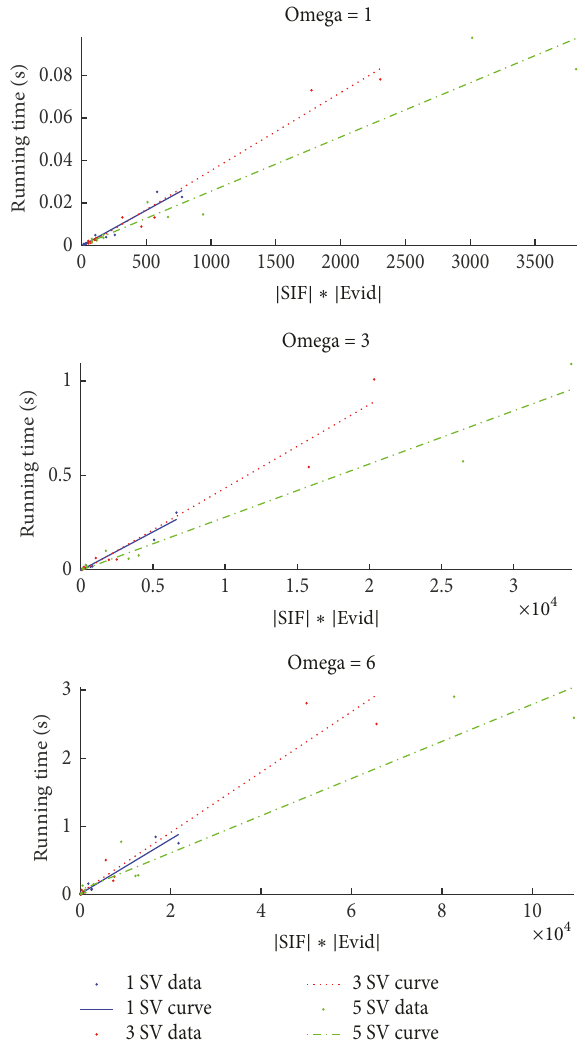
Figure 9: Running time comparison of approximation and exact